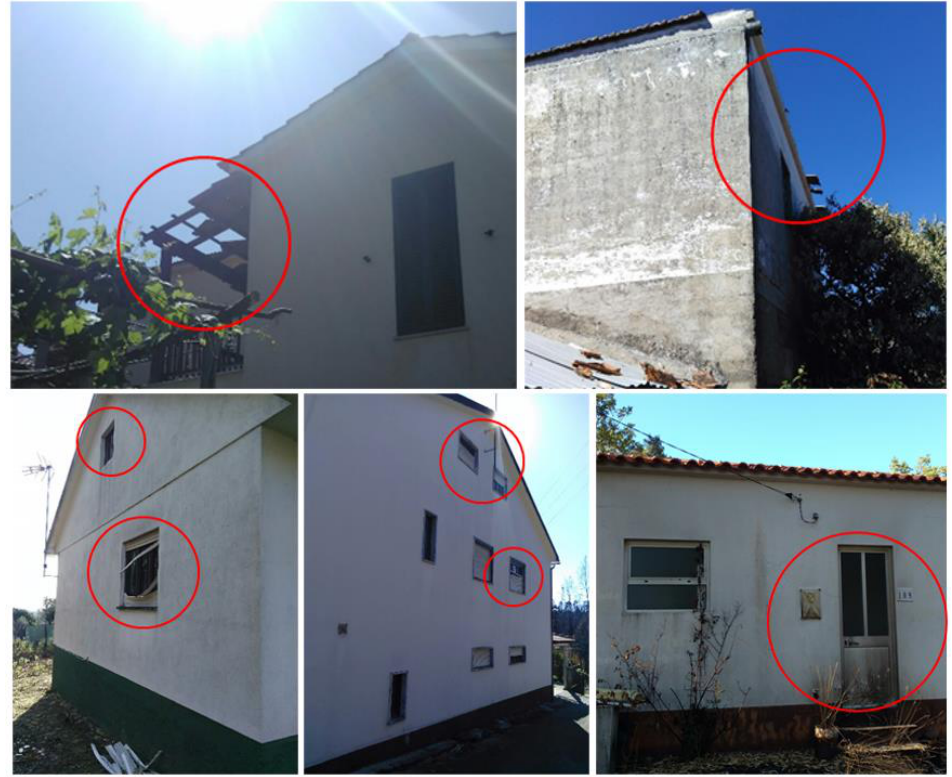
Figure 6. Details of some elements that were damaged by the fire but with no ignition to the house.